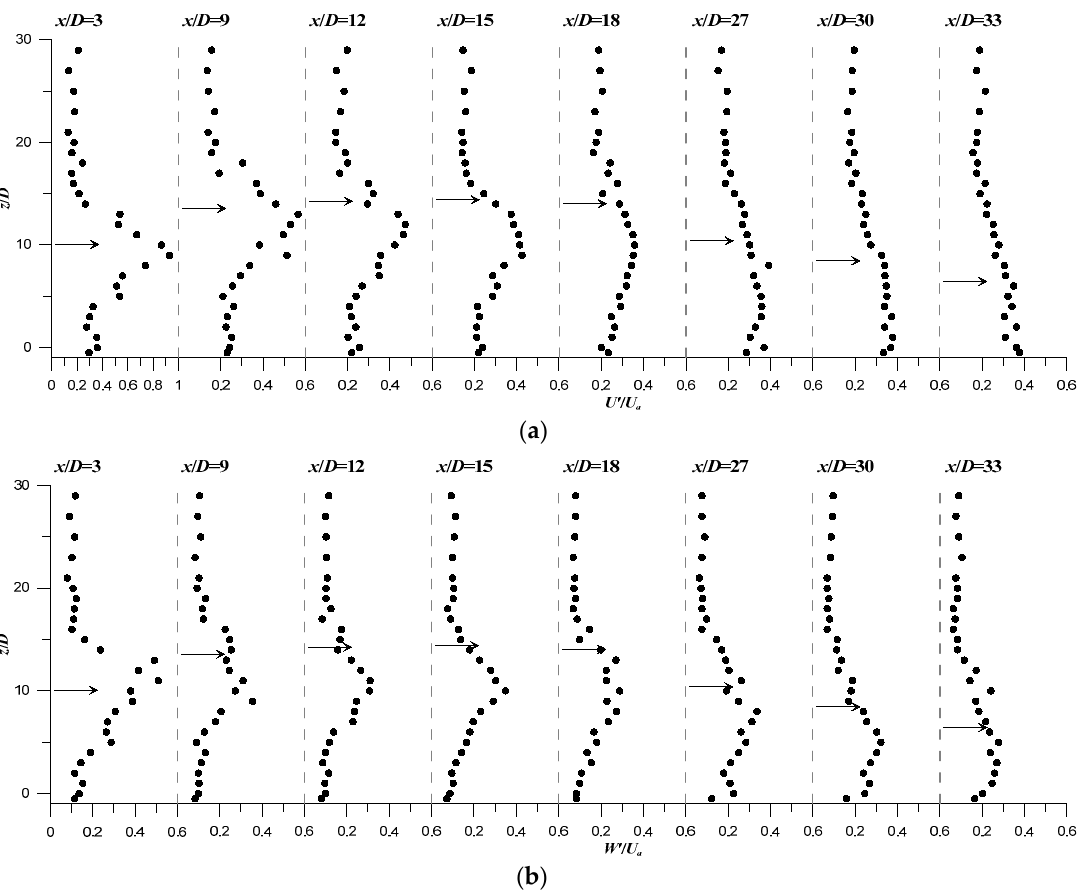
Figure 8. Vertical profiles of the flow turbulence intensity at different downstream positions x / D along the plane of flow symmetry ( y = 0) of run R1: ( a ) U’ / U a ; ( b ) W’ / U a . The horizontal arrow on the profiles indicate the position of the jet axis.